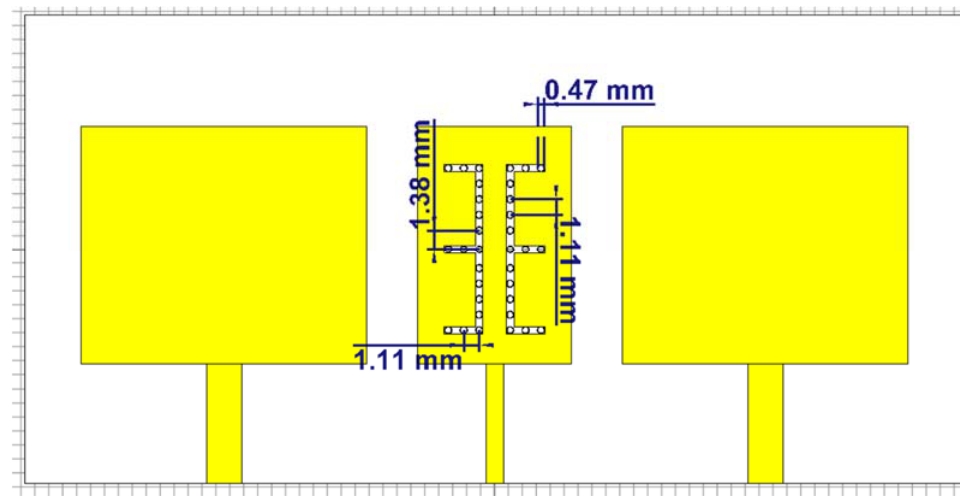
Figure 8. Geometry of 2 × 1 microstrip patch antenna array with slotted MTM-DS.